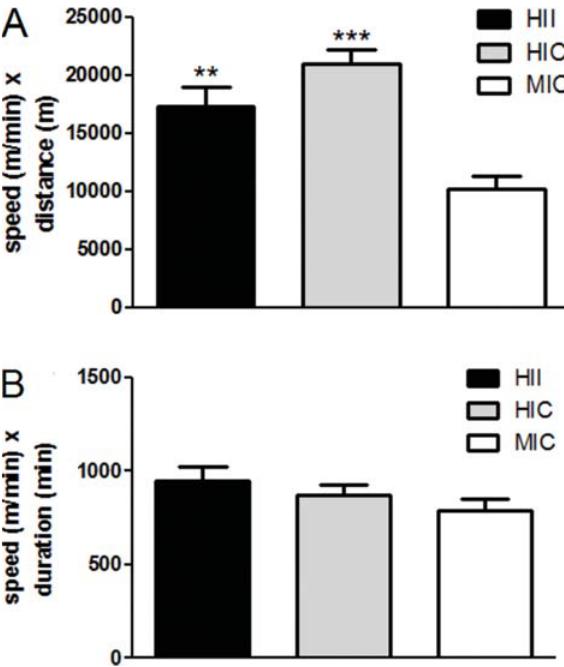
Figure 2. Product between running speed and distance ( A ), and between running speed and duration ( B ). **P o 0.01,